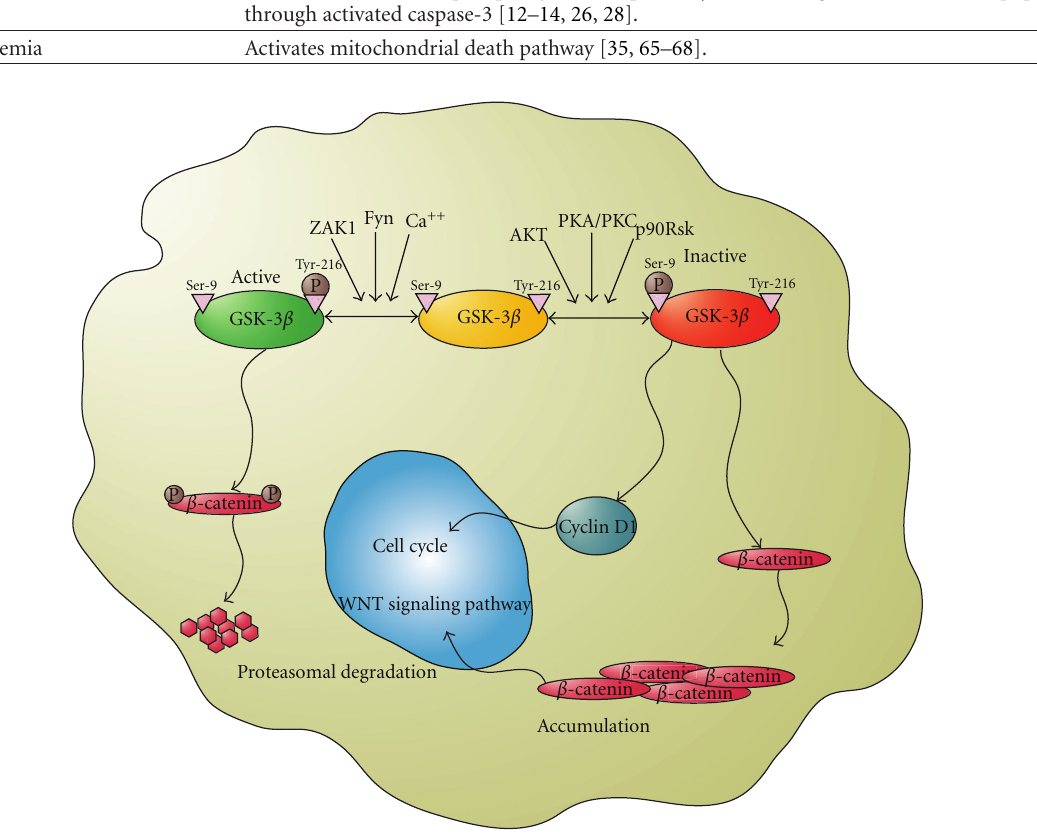
Figure 2: Regulation of GSK-3 β . GSK-3 β is a multifunctional kinase that has a role in various signaling pathways that regulate cell fate. ZAK1 or Fyn can phosphorylate Tyr-216 which increases the GSK-3 β activity. GSK-3 β can phosphorylate downstream targets like β -catenin and degrade it through the ubiquitin-proteasome system. Akt and PKC on the other hand can attenuate GSK-3 β enzymatic activity